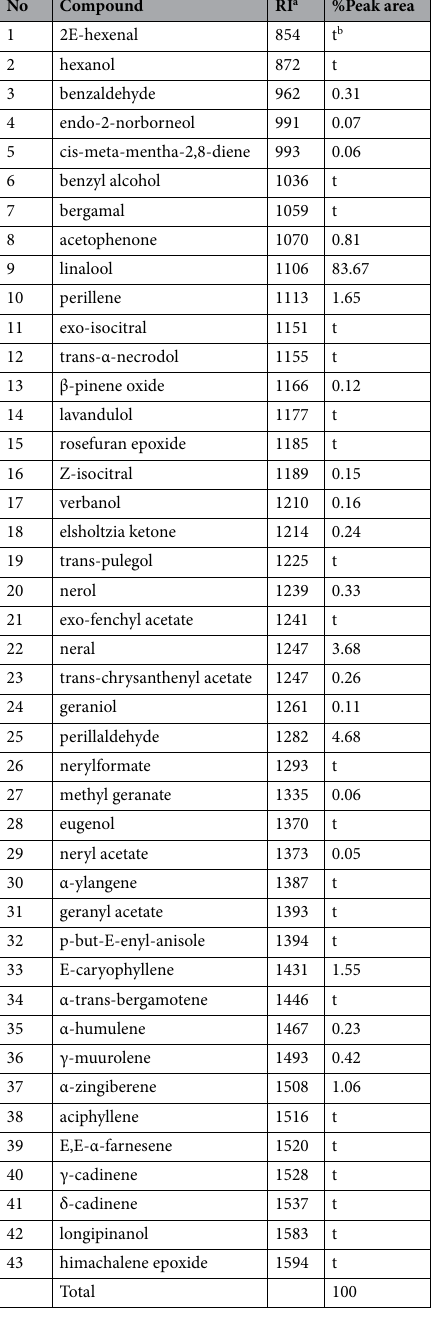
Table 1. Chemical constituents of E. beddomei essential oil. a Calculated retention indices obtained from a DB-5 column. b Trace amount <